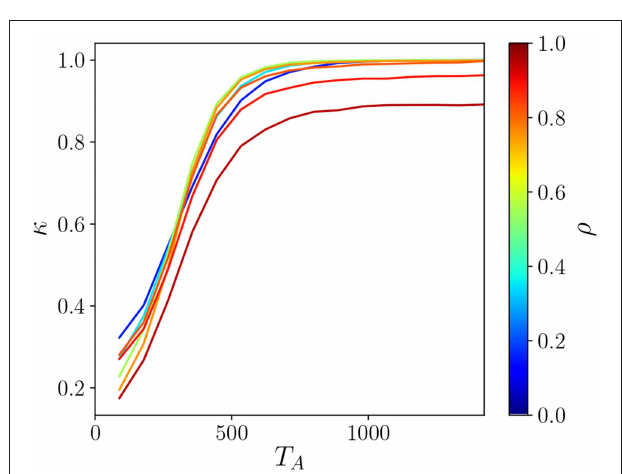
FIGURE 8 | The fragmentation index κ as a function of the active scent time T A for thermalized systems with parameters L ρ . 0.75, at low T A values the territories are concave and as a result are more prone to fragmentation resulting in low κ . As the T A is increased, the territories become more convex becoming more resistant to fragmentation resulting in κ 1 for T A & 800. On the other hand, for ρ & 0.75 fragmentation persists in = the system regardless of T A .